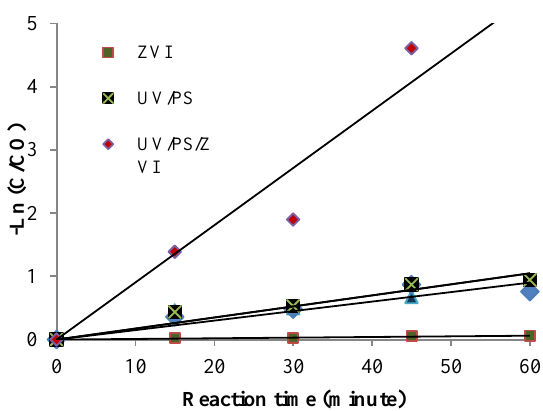
Figure 6. First order plot for degradation of p-chlorophenol using different oxidation processes in optimum